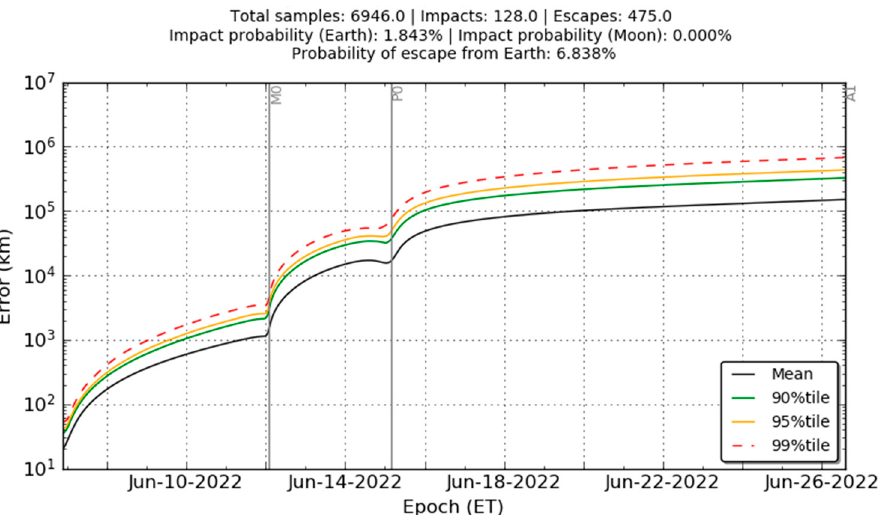
Figure 4. Statistics of the uncontrolled trajectory error with respect to the nominal trajectory from the deployment up to the first apogee A1.